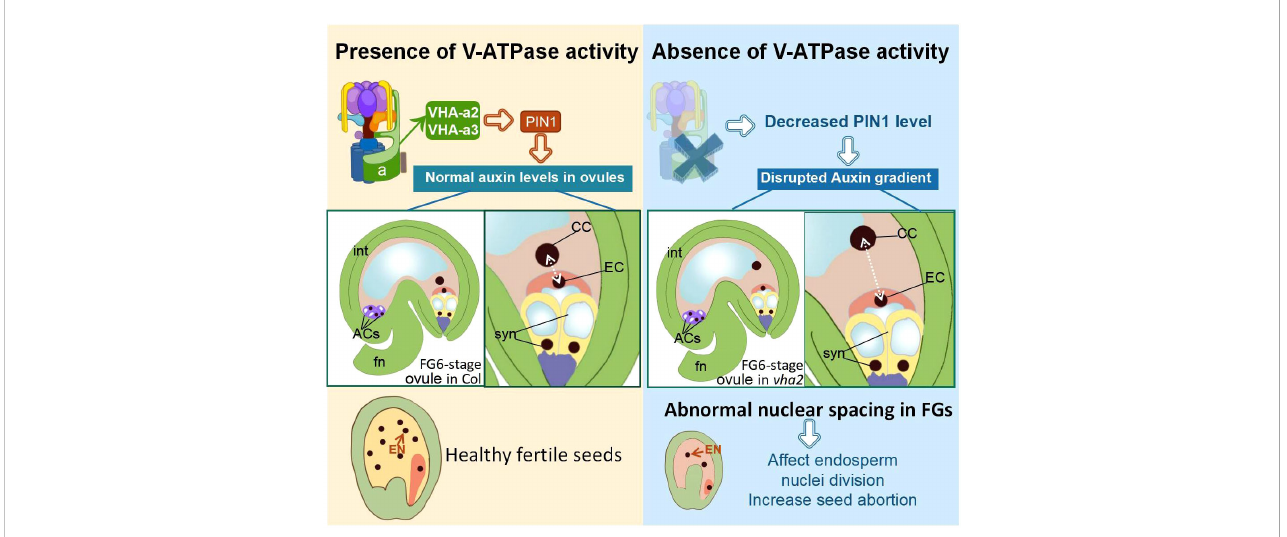
FIGURE 8 Schematic diagram of the role of V-ATPase on FGs and later endosperm development. fn funiculus, syn synergid cell, EC egg cell, CC central cell, ACs antipodal cells, int integuments (inner and